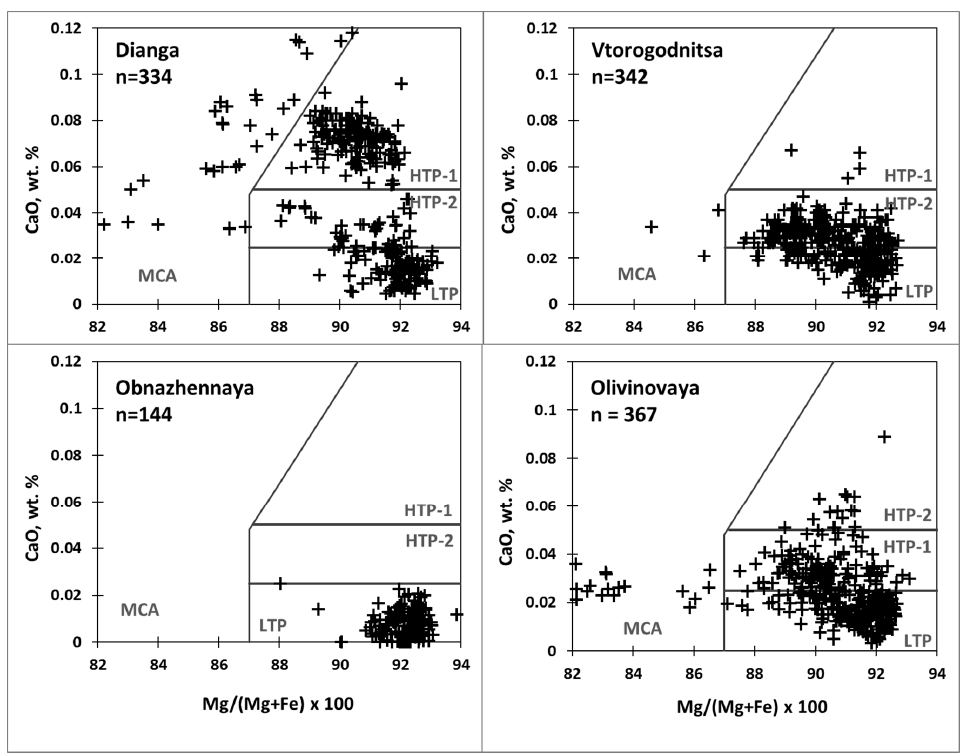
Figure 5. Pluses (+) are compositions of xenolithic olivines from kimberlites in the Siberian craton. Contoured fields represent different olivine types: MCA = low-Cr megacryst assemblage, LTP = low- temperature peridotites < 1100 °C, HTP-1 = high-temperature peridotite > 1300 °C, HTP-2 = high- temperature peridotite 1100–1300 ° С . n is number of analyzed grains. See supplementary Table S1. Table 1. Xenolithic olivines of different types: percentages in different kimberlites. Colossus kimberlites data from work in [29]. Symbols for kimberlite types are same as in Figure 5. n is number of analyzed grains.